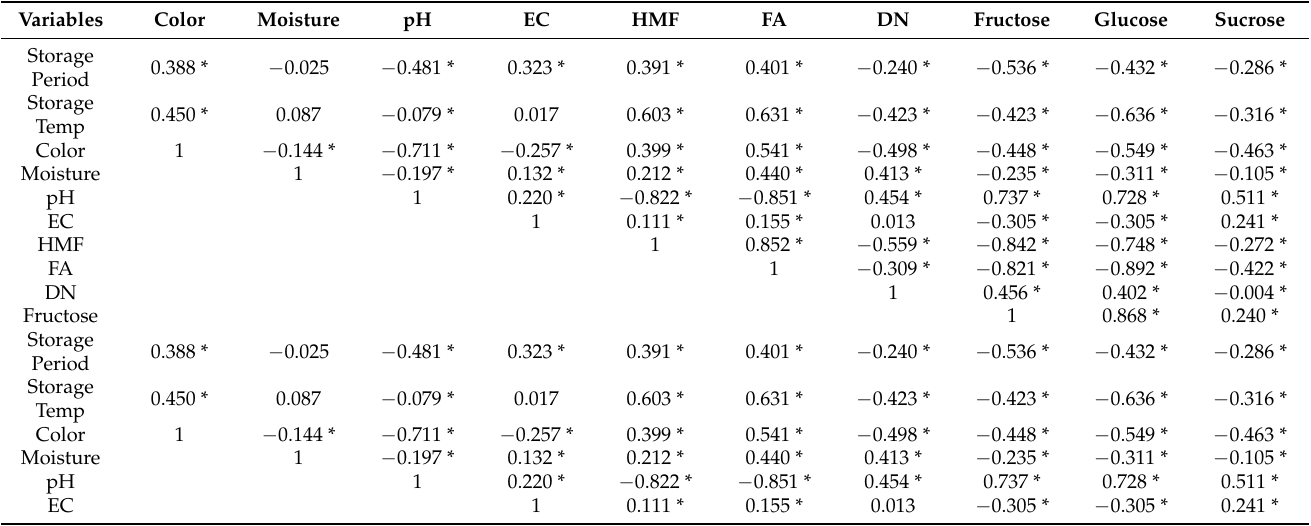
Table 4. Pearson correlation coefficients between physicochemical characteristics of Talh Acacia gerrardii